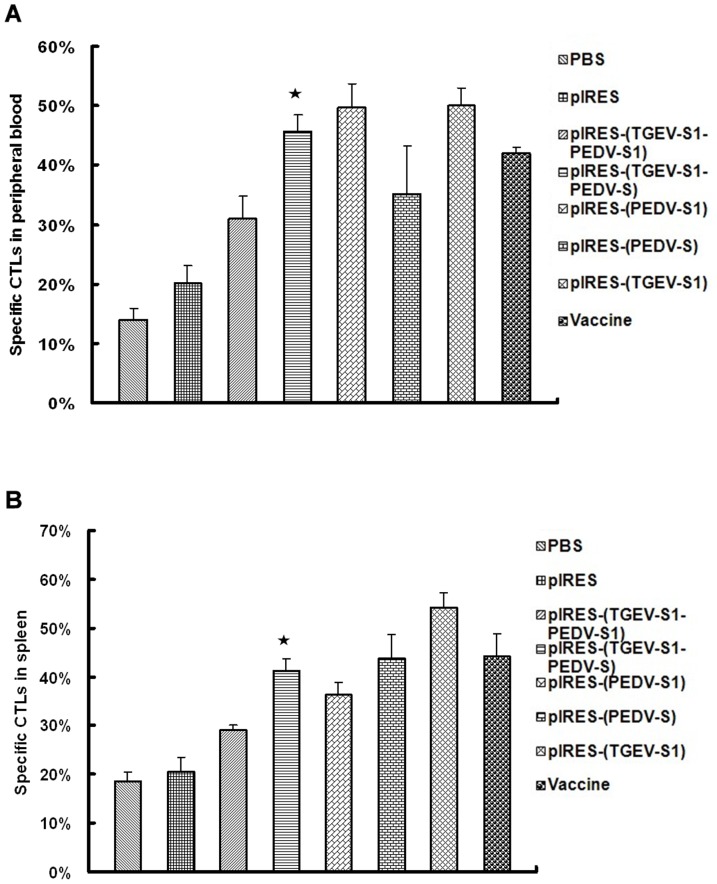
Activity of CTLs in spleen and peripheral blood.Cytotoxicity was analyzed using the LDH release assay. The release of LDH which is directly proportional to CTL activity was monitored as a function of time over a period of 42 days. ★: p<0.01 (highly significant) compared with PBS, pIRES treatment groups.